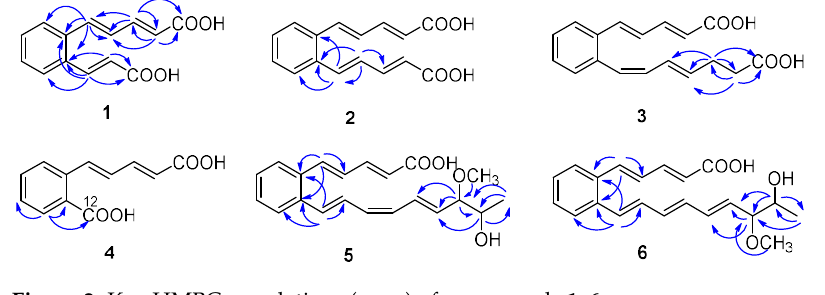
Figure 2. Key HMBC correlations ( ) of compounds 1 − 6 . Table 1. NMR data for 1 − 3.